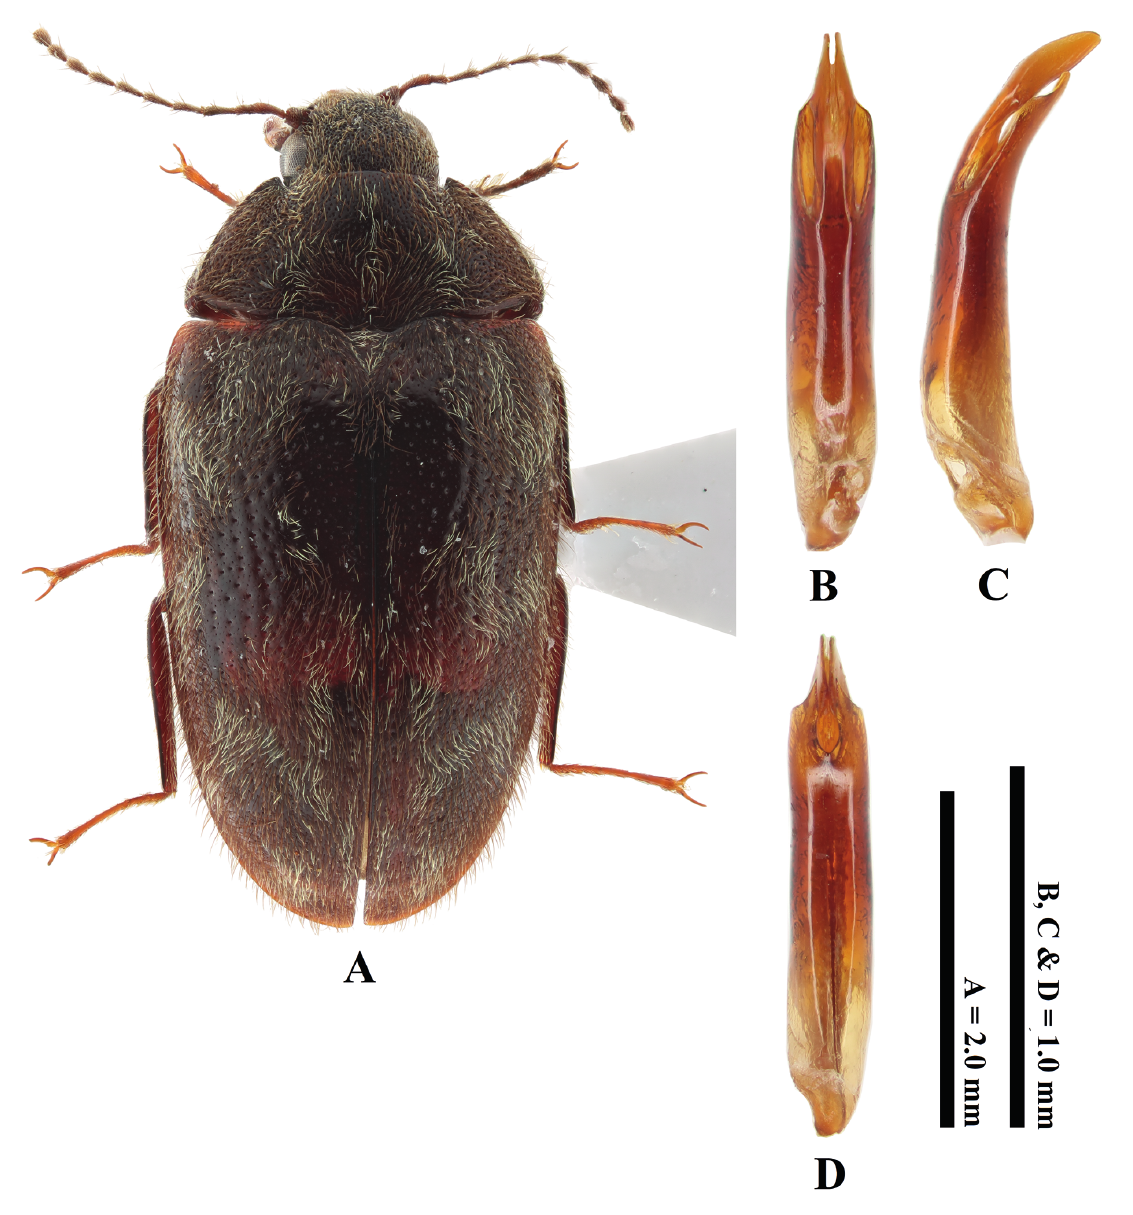
Fig. 2. Caccothryptus arakawae sp. nov., ♂, holotype (NHMUK011225268). A . Dorsal habitus. B . Genitalia, dorsal. C . Genitalia, lateral. D . Genitalia,